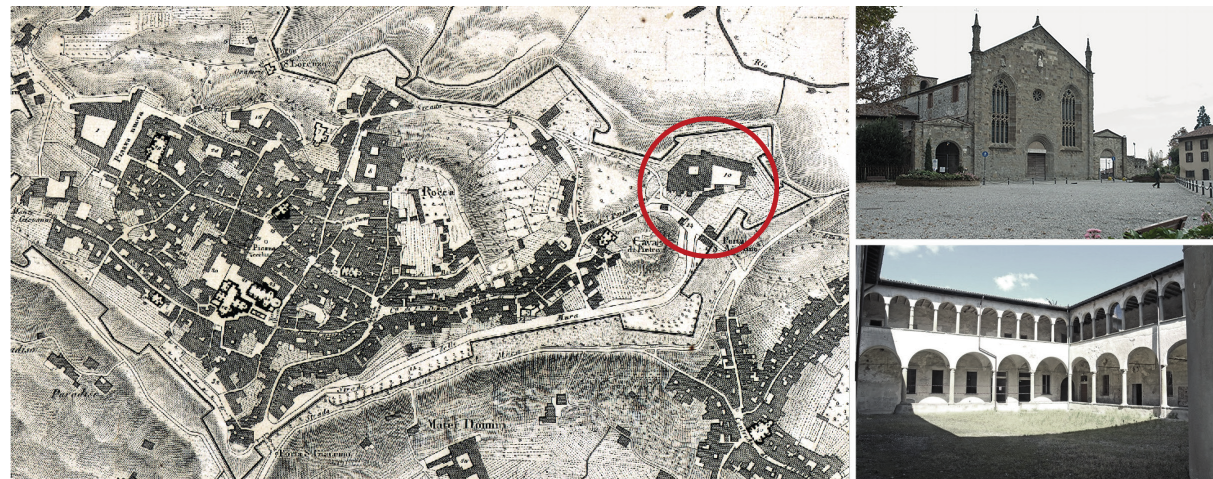
Figure 1. On the left, the monumental architectural structure of Sant’Agostino in the first scientific map of the city of Bergamo drawn up by the engineer and architect Giuseppe Manzini in 1816. On the right, the church and the small cloister before the restoration (@University of